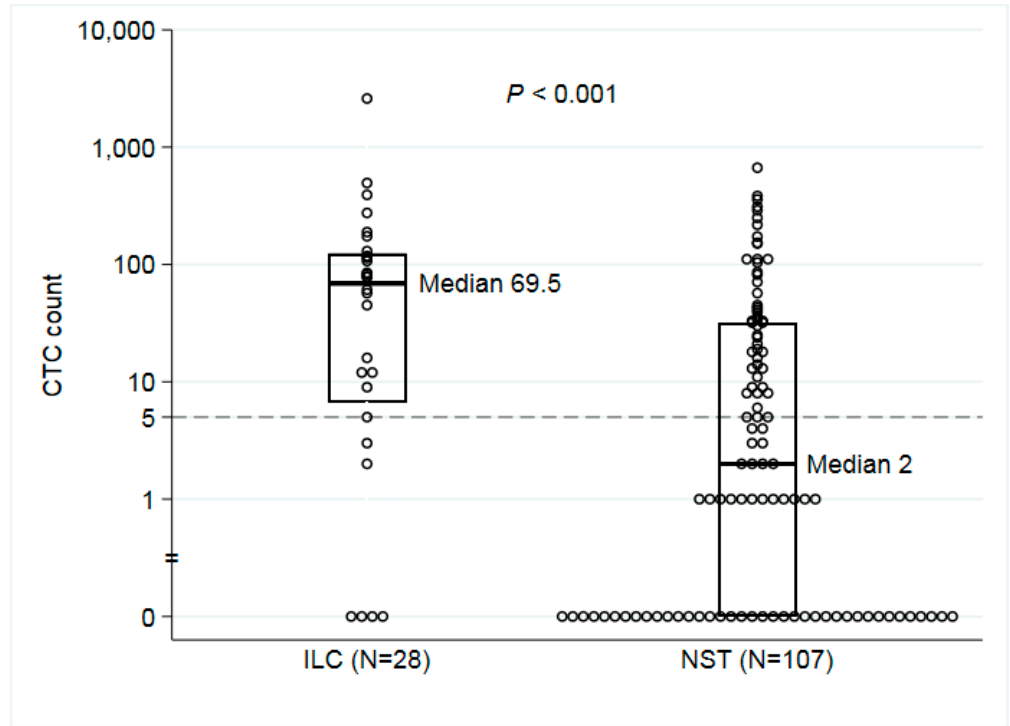
Figure 2. Circulating tumor cell (CTC) count at baseline by histopathological type. Abbreviations: ILC, invasive lobular carcinoma; NST, invasive ductal carcinoma of no special type; CTC count, number of CTCs per 7.5 mL